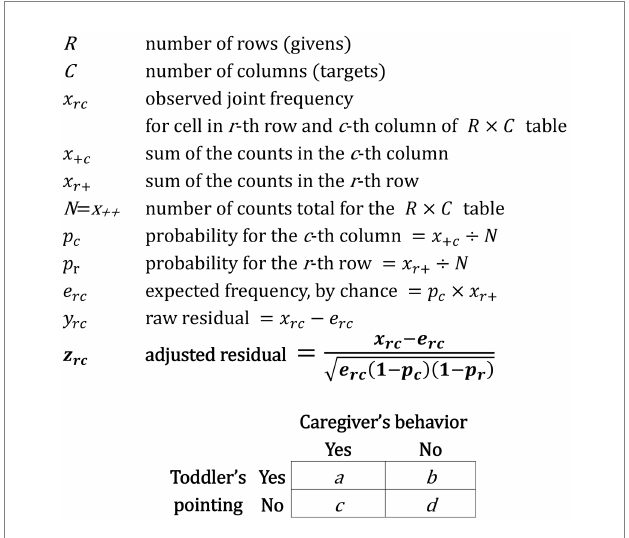
FIGURE 2 Definition for z -score (adjusted residual, z rc ) based on the contingency table used in the present study (Bakeman and Quera,